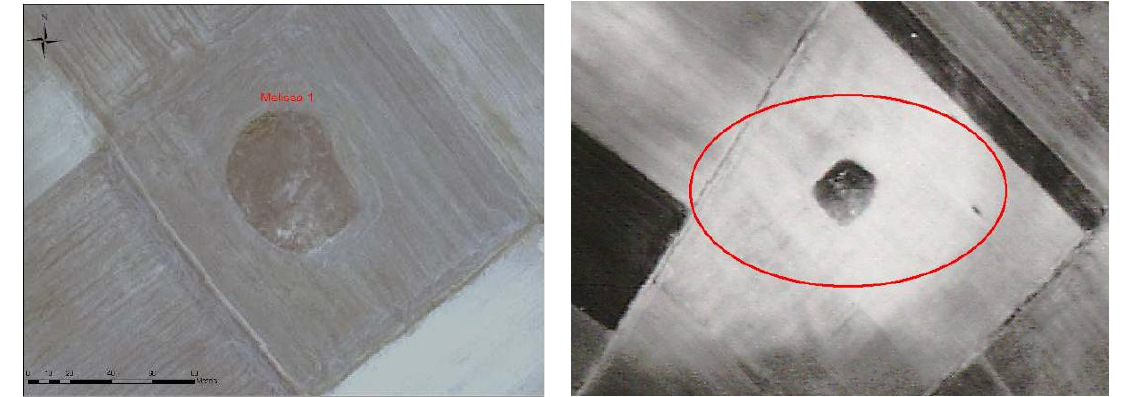
Figure 5. IKONOS image. RGB – 321 - Melissa 1 Settlement (left). Melia 2 Settlement – Airphoto image